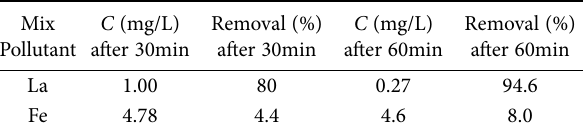
Table 3. Flotation results for 100mL mixed ion solutions of 5mg/L lanthanum and iron (initially) using crystallised N-octanoyl-cys surfactant with dry air ion flotation, the batch process had an initial